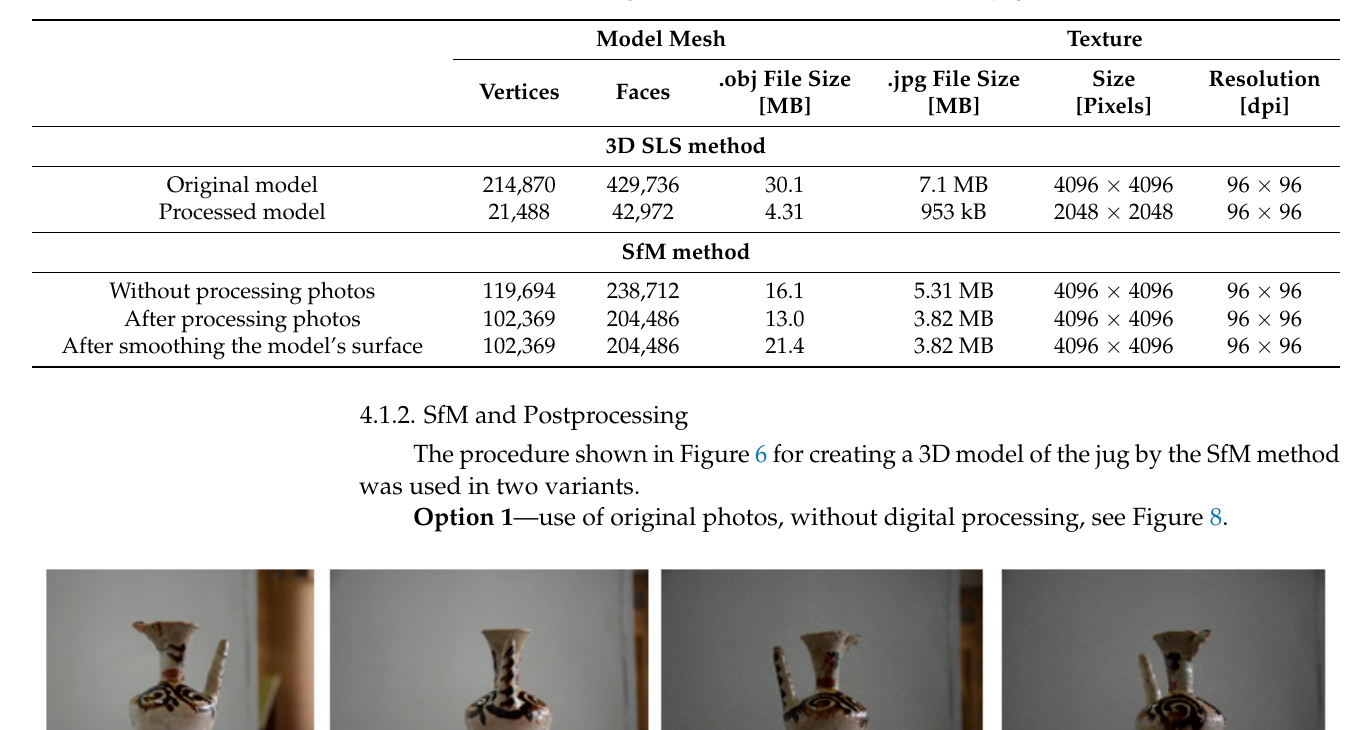
Table 4. Parameters of the digital 3D model and the texture of the jug.